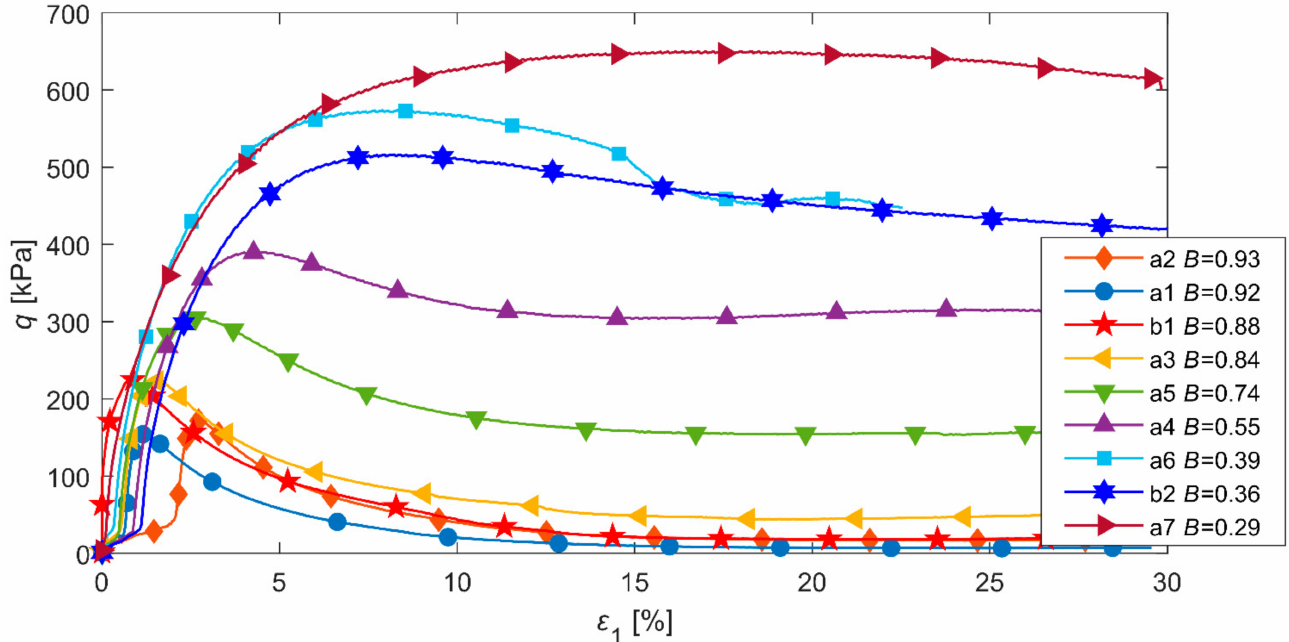
Figure 11. Stress–strain response of OZM50 tailings at different levels of saturation: stress deviator vs. axial strain.